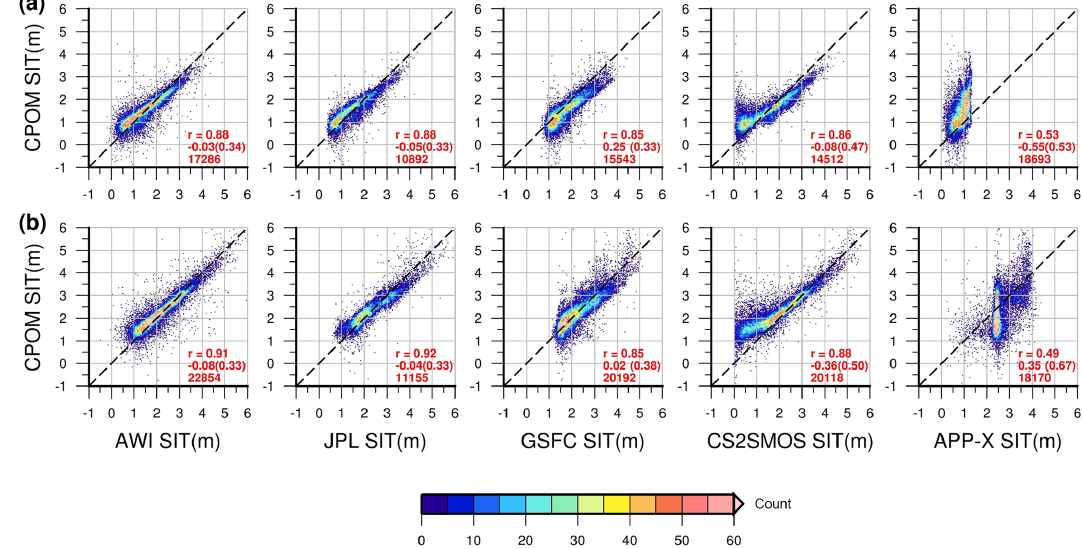
Figure 4. Comparisons of sea ice thickness for each product and the reference data set for (a) October–November and (b) March–April, for the period 2010–2018, regions 1–14 north of 65 ◦ N, subject to data availability (Table 1). Colour indicates measurement density, derived from the number of data points within each 0.05m cell. Statistics for correlation ( r ), mean difference (SD) and number of data points are